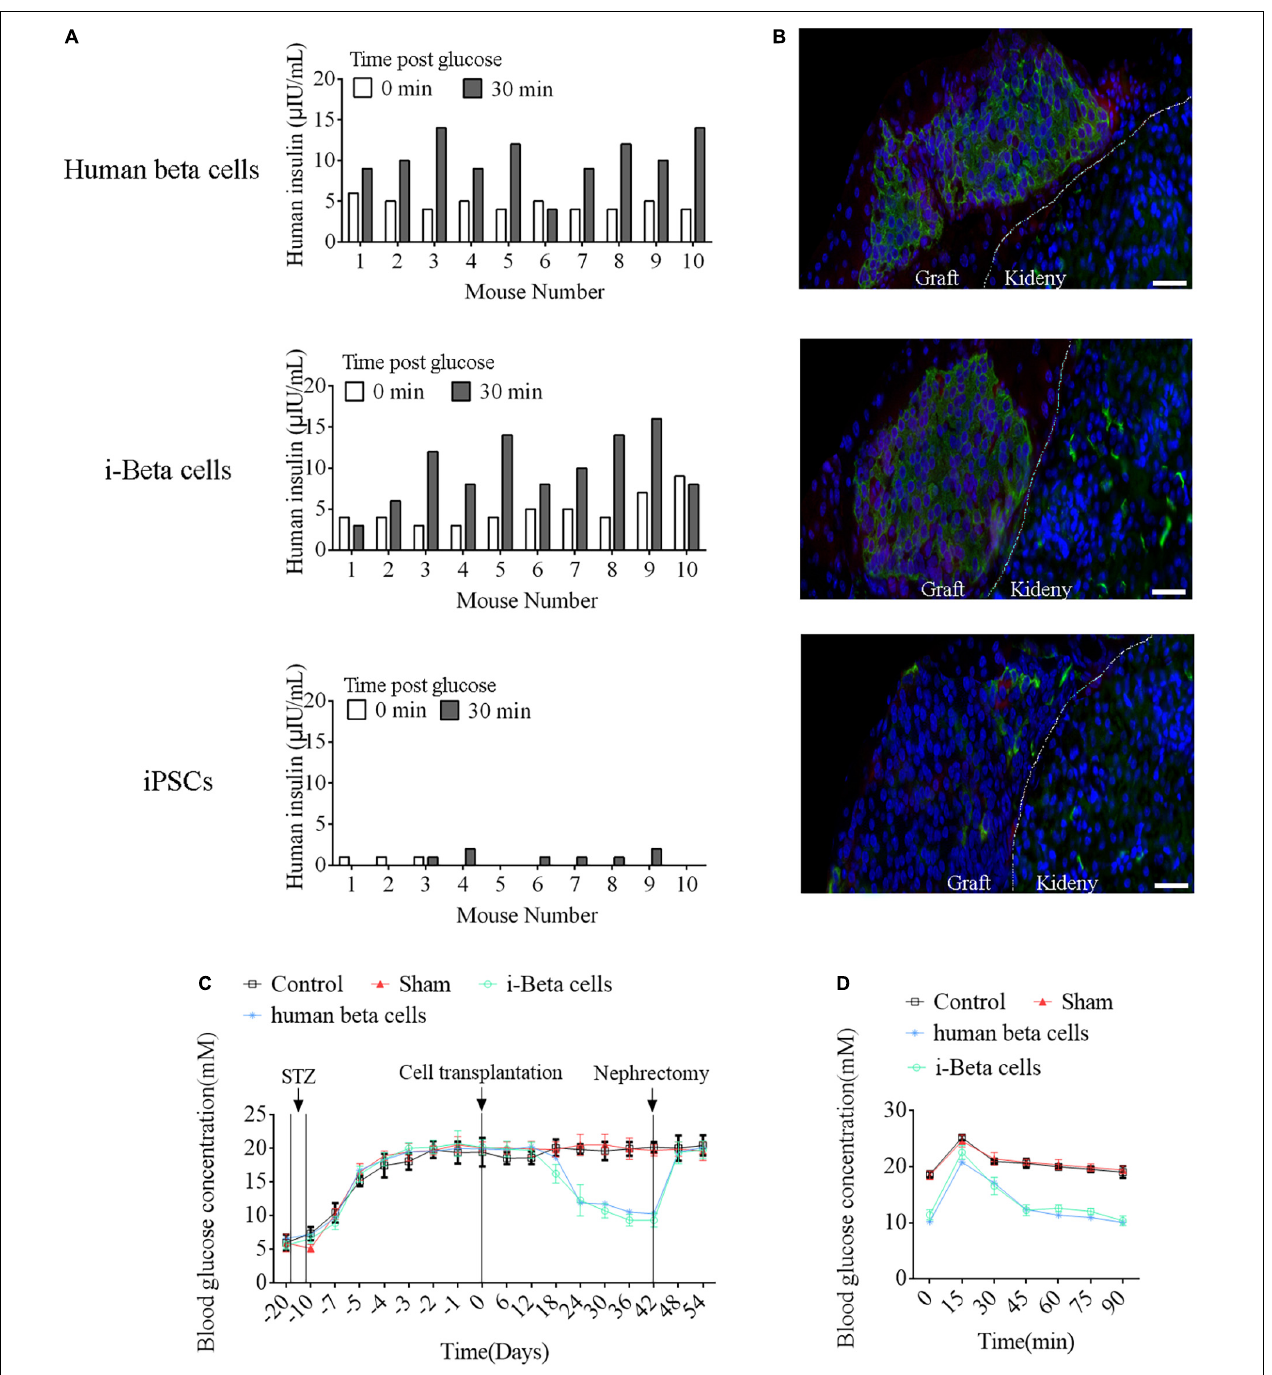
FIGURE 9 | Functional analysis of i-Beta cells in vivo after transplantation. (A) ELISA detection of human insulin in serum of immunodeficient SCID mice transplanted with human beta cells, i-Beta cells, or iPSCs. Measurements were performed before (white bars) and at 30 min after (black bars) a glucose injection at 2 weeks post-transplantation. (B) Representative immunofluorescence images of kidneys at 2 weeks post-transplantation stained for insulin to confirm the presence of engrafted cells. Scale bar = 50 µ m. (C) Transplanted human beta cells and i-Beta cells ameliorated hyperglycemia in diabetic mice. Mice were treated with mouse-specific beta cell toxin STZ (intraperitoneal injection for 6 days) to ablate endogenous beta cells. Human beta cells or i-Beta cells (2 × 10 6 cells/mouse) were transplanted under the kidney capsule of diabetic mice. Fasting blood glucose was assessed every 6 days and a survival nephrectomy was performed on all mice on day 42 to remove the engrafted kidney. Unilateral nephrectomy of human beta cells or i-Beta cell graft-bearing mice resulted in a rapid rise in fasting blood glucose levels ( n = 5). (D) Blood glucose levels were measured by a glucose tolerance test at 6 weeks post-transplantation. Human beta cells and i-Beta cells rapidly ameliorated hyperglycemia in diabetic mice ( n =